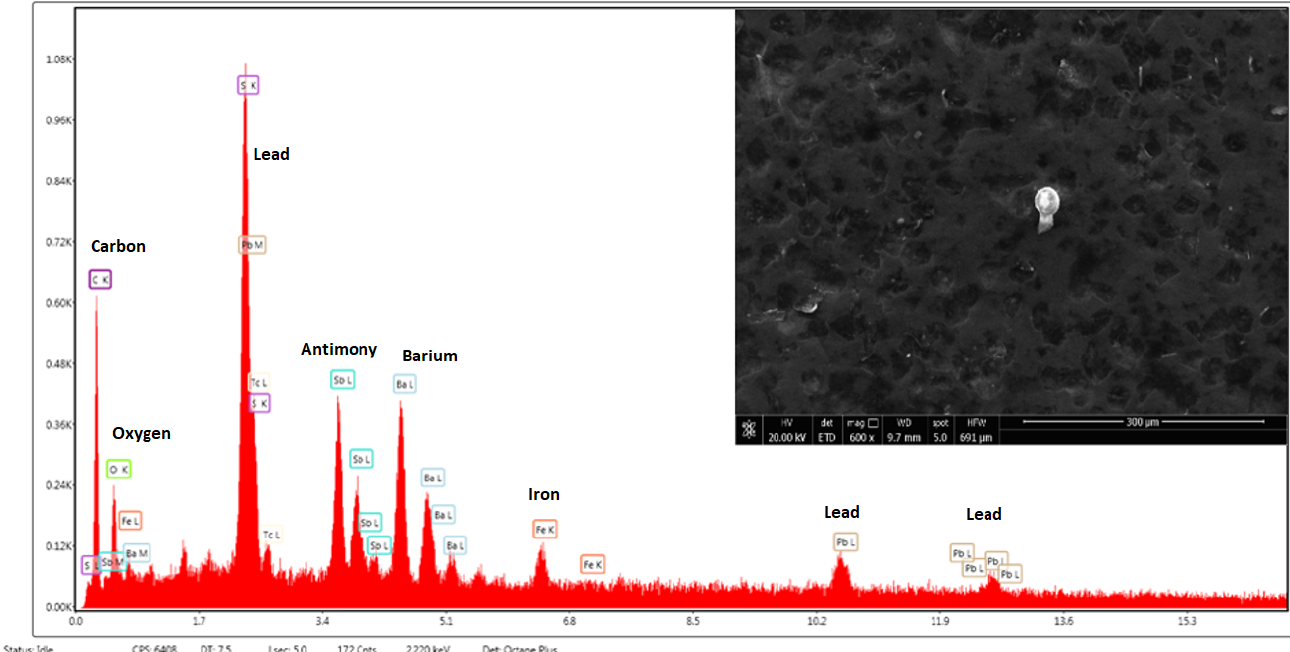
Figure 2. A typical SEM picture and EDS spectrum of GSR particles generated from the discharge of a low ‐ caliber firearm (Glock 19 pistol (9 × 19 mm)).